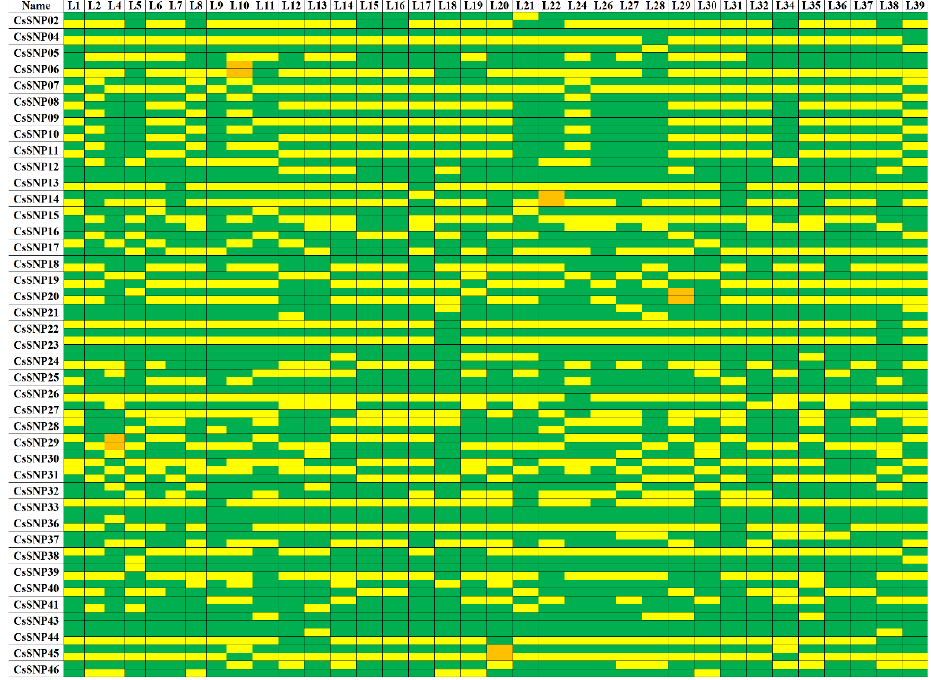
Figure 4. Fingerprints of the 35 tea germplasms. Each line represents one marker, and each column represents one germplasm. Green represents the nucleotide in the reference genome, yellow represents the mutation, and missing data are shown in orange.